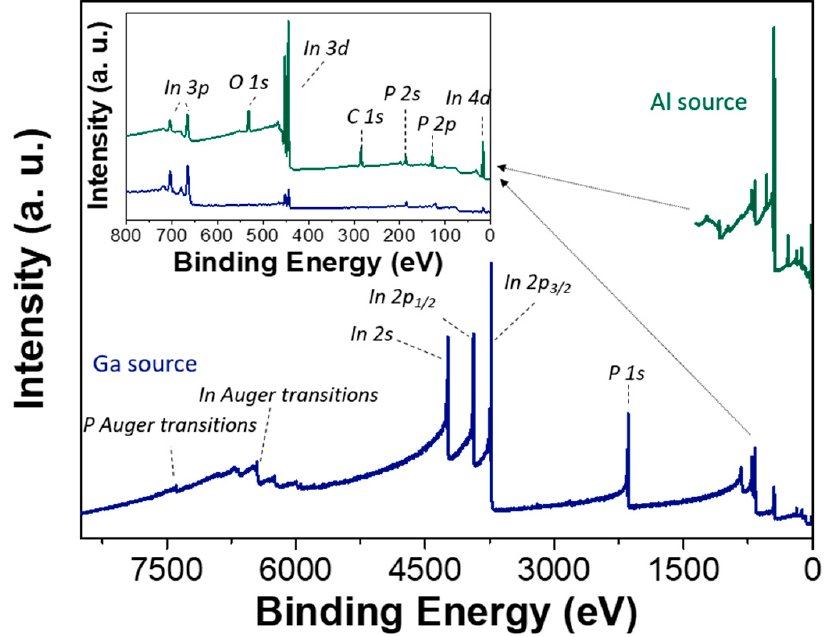
Figure 2. Widescans on InP substrate, using a conventional Al source (green) and a high energy Ga source (blue), with a specific inset of the 800–0 eV region. The high energy Ga source survey spectrum shows an absence of O 1s and C 1s.